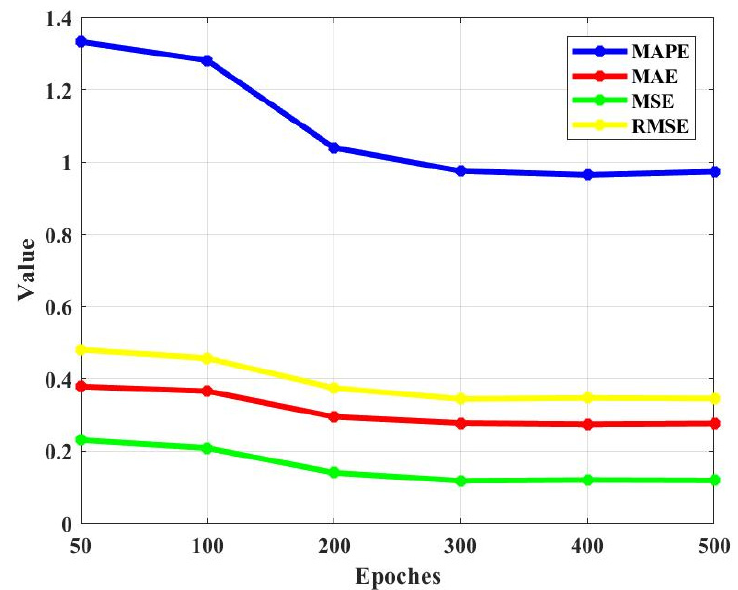
Figure 12. The experimental results of the new hybrid SST correction model in different epochs. The units of RMSE, MAE, and MSE are °C and the unit of MAPE is %. units of RMSE, MAE, and MSE are ◦ C and the unit of MAPE is